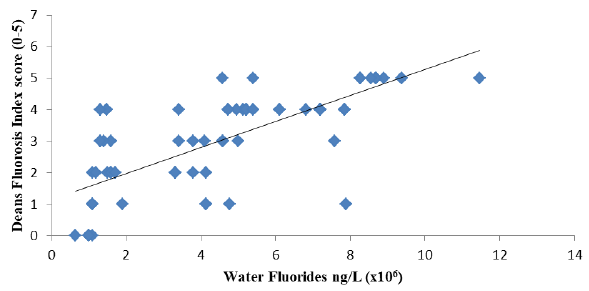
Figure 5: Relationship between Water Fluoride and Dental Fluorosis of RM Participants r =